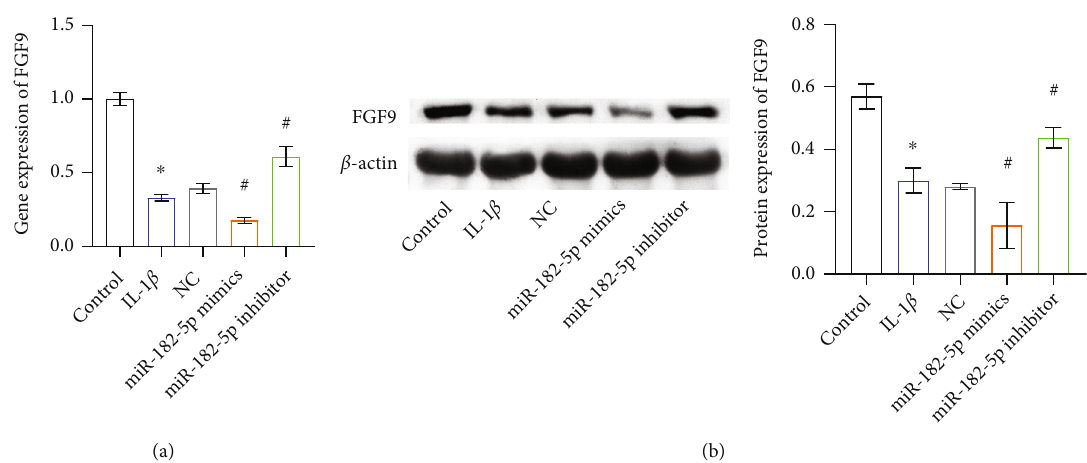
Figure 3: miR-182-5p targeted FGF9 expression in chondrocytes. (a) The gene expression of FGF9. (b) The protein expression of FGF9 was analyzed by WB. * P < 0 : 05 vs. control. # P < 0 : 05 vs. NC.